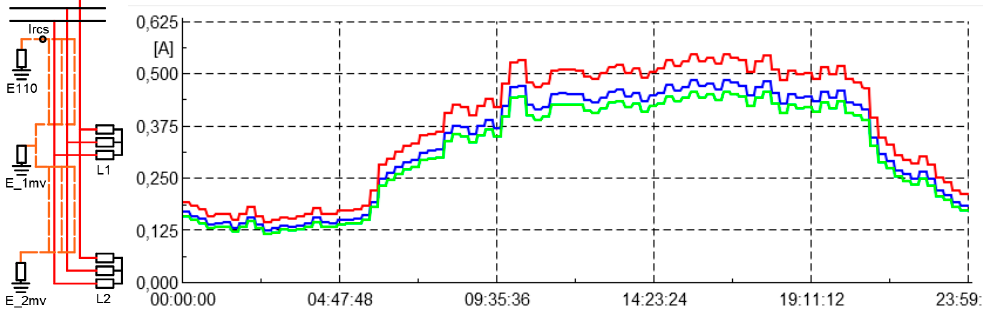
Figure 11. Impact of R e2MV on I r cs (from above 2, 4 and 6 Ω ; cable length 1